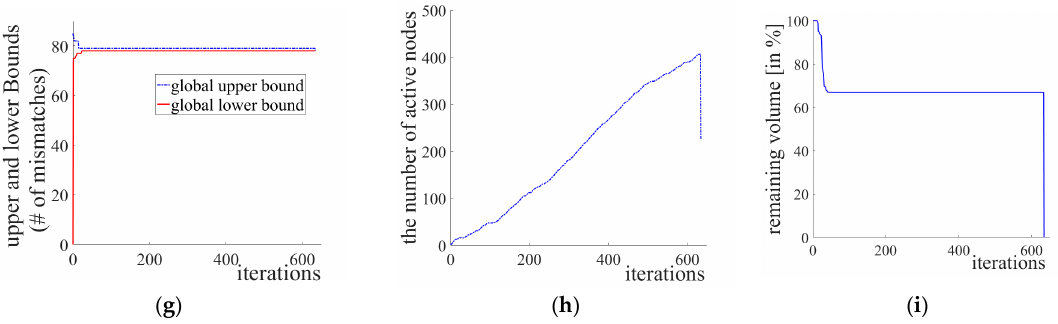
Figure 2. 3D registration results for the proposed method: ( a , b ) two input range images, ( c ) initial pose of two input data ( a , b , d ) range images aligned by our branch-and-bound, ( e ) the correct and incorrect matches detected by the proposed method, where blue and red lines denote a correct one and a mismatch, respectively, ( f ) the refined registration result of ( d ) by iterative closest point (ICP), ( g ) convergence of the global lower and upper bounds of our branch-and-bound, ( h ) number of active nodes in our branch-and-bound, and ( i ) the remaining volume of our branch-and-bound search space.